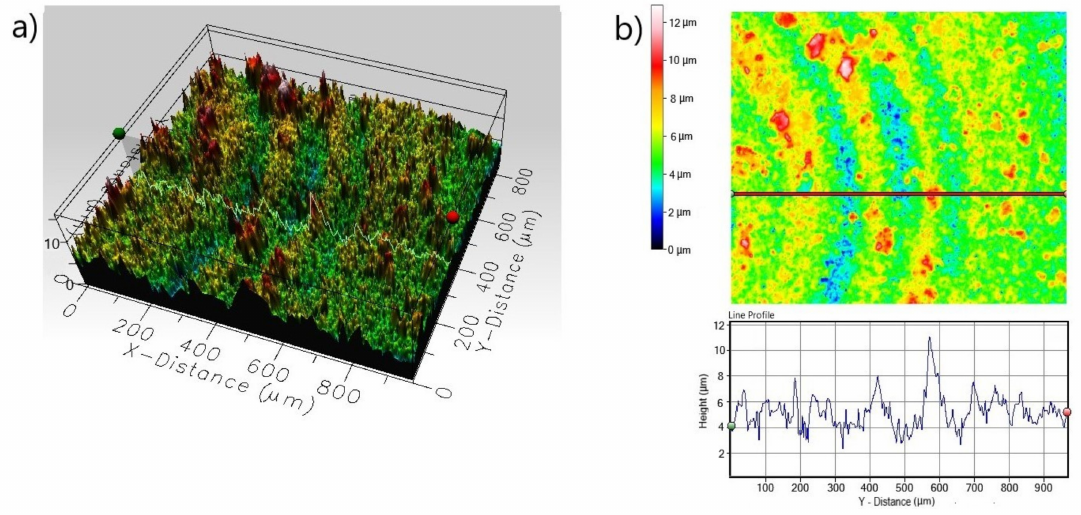
Figure 9. 3D profile ( a ) and 2D profile ( b ) of the corroded surface of borided Nickel 201 after the corrosion resistance test in a 3.5% NaCl